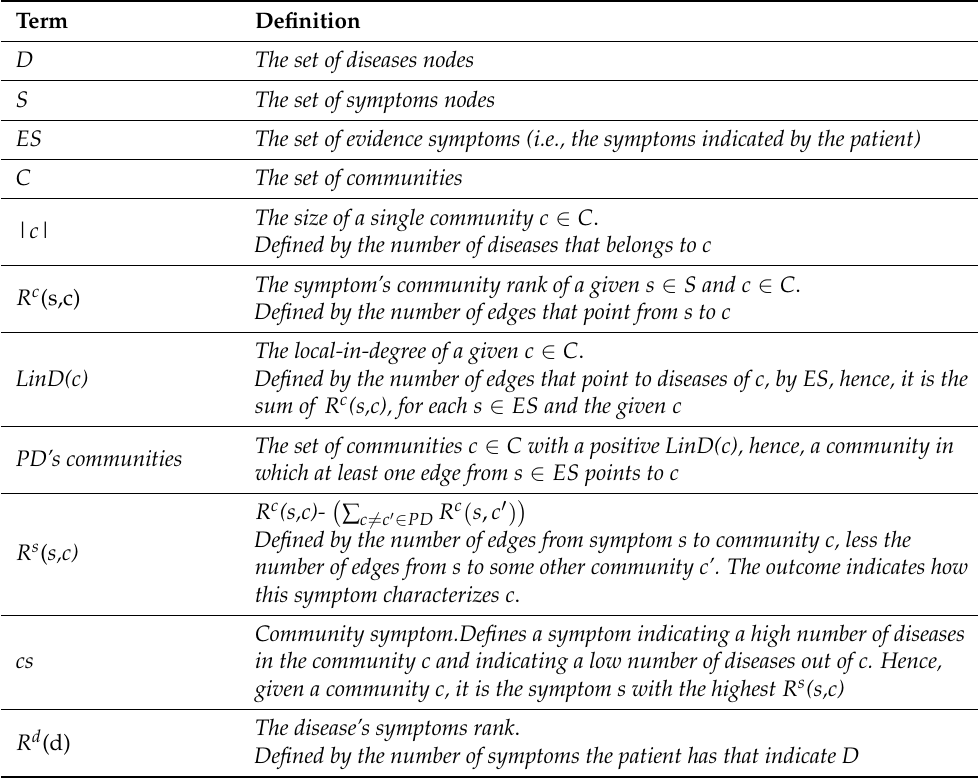
Table 2. Definition of terms used in our